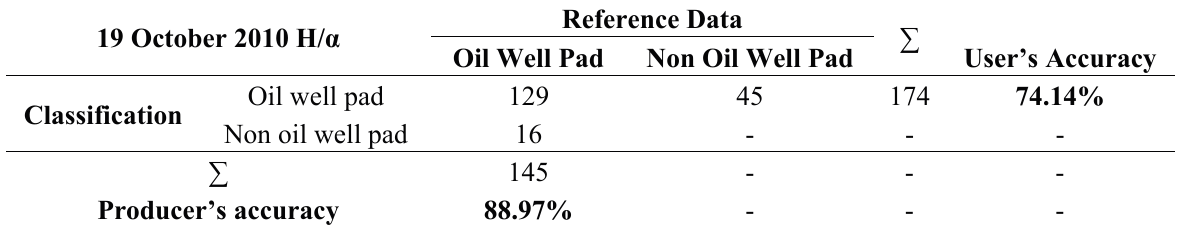
Table 5. Number-based accuracy assessment for TerraSAR-X acquisition 19 October 2010—H/ α .